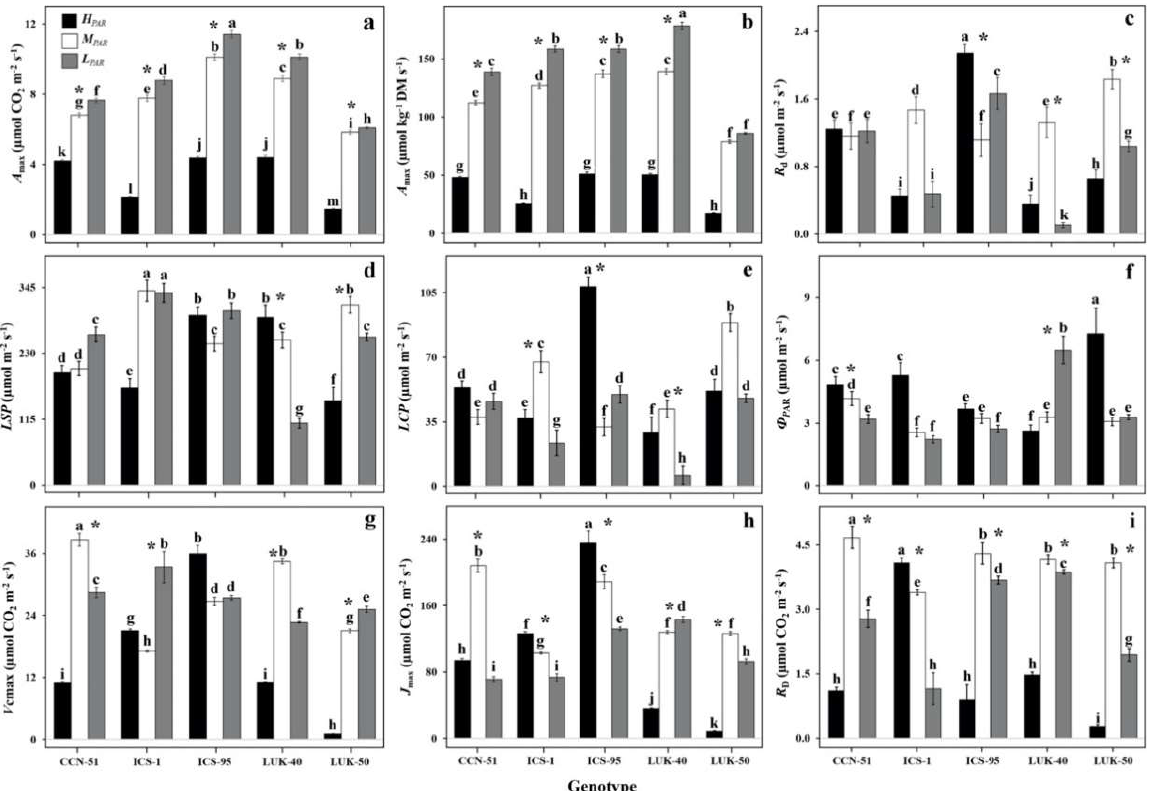
Figure 3. Parameters derived from photosynthetic light (A/PAR) and CO 2 (A/C i ) response curves for five genotypes of cacao in three levels of radiation considered were high mean daily incident photosynthetically active radiation (H PAR , 2100 ± 46 mol m − 2 s − 1 ) that was in full sun, medium mean daily incident photosynthetically active radiation (M PAR , 1150 ± 42 mol m − 2 s − 1 ) and low mean daily incident photosynthetically active radiation (L PAR , 636 ± 40 mol m − 2 s − 1 ). ( a , b ). A max : Light-saturated maximum net carbon assimilation rate; DM: Dry mass; ( c ). R d : Dark respiration rate; ( d ). LSP: Light saturation point; ( e ). LCP: Light compensation point; ( f ). Φ PAR : Quantum efficiency; ( g ). V cmax : Maximum carboxylation rate; ( h ). J max : Maximum rate of regeneration of ribulose-1,5-bisphosphate (RuBP) controlled by electron transport; ( i ). R D : Leaf respiration in light conditions. a,b,c : Values in bars with different letters indicate significant differences between genotypes of cacao × radiation level (post hoc LSD Fisher, p < 0.05). *: Means statistical differences between radiation levels in each cocoa genotype. The results include means ± SE ( n = 4). Statistics are defined as in Figure 1.